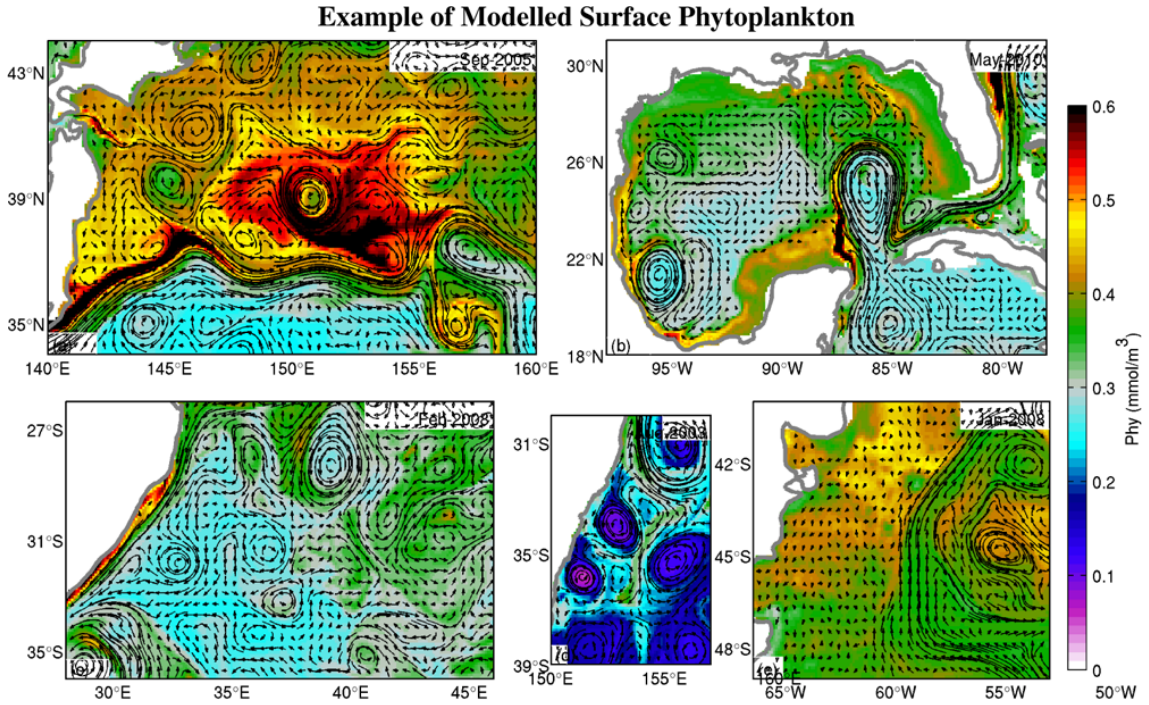
Fig. 16. Example of daily averaged modelled surface phytoplankton for the (a) Kuroshio, (b) Gulf of Mexico, (c) Agulhas, (d) EAC, and (e) BMC region. The daily averaged velocity at 50m depth is overlaid on the model fields, with one vector every 0.4 ◦ . The length of each vector represents the trajectory of a particle over 2